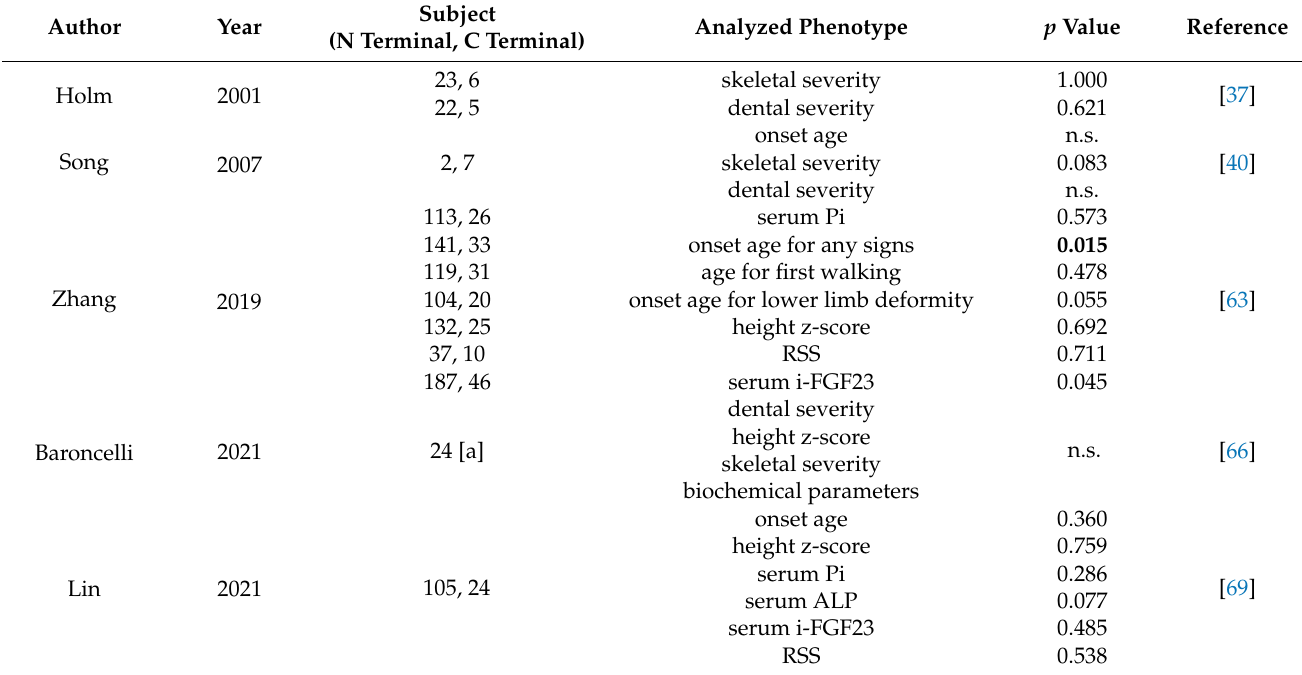
Table 3. Summary of analyses on PHEX variant